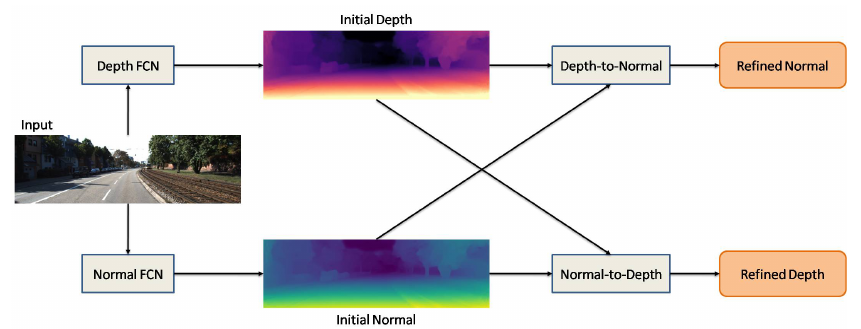
Figure 11. Developed geometric neural network by Qi et al.